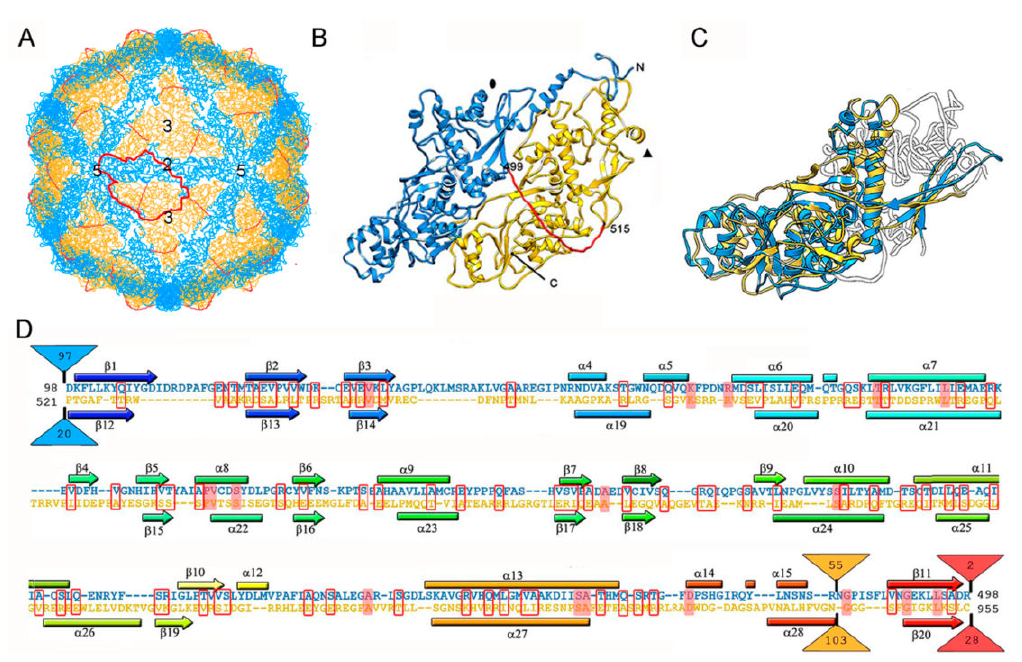
Figure 3. PcV T = 1 capsid protein; cryo-EM-based structure. ( A ) T = 1 capsid of PcV viewed along a two-fold axis of icosahedral symmetry, showing the N-terminal domain A (1–498, blue), the linker segment (499–515, red), and the C-terminal domain B (516–982, yellow), with the boundaries of an asymmetric unit outlined in red. Numbers indicate icosahedral symmetry axes. ( B ) Top view of the atomic of the PcV CP (3j3i; 982 residues). Symbols indicate icosahedral symmetry axes. ( C ) PcV capsid protein is a structural duplication. Superimposed A and B domains (white segments indicate non-superimposed regions for both domains). ( D ) Sequence alignment of domains A (blue) and B (yellow) resulting from Dali structural alignment. α -helices (rectangles) and β -strands (arrows) are rainbow-colored from blue (N terminus) to red (C terminus) for each domain. Triangles represent non-aligned segments (sizes indicated): the orange triangle indicates the single “hotspot” on the outer capsid surface. Strictly conserved residues are on a red background and partially conserved residues are in a red